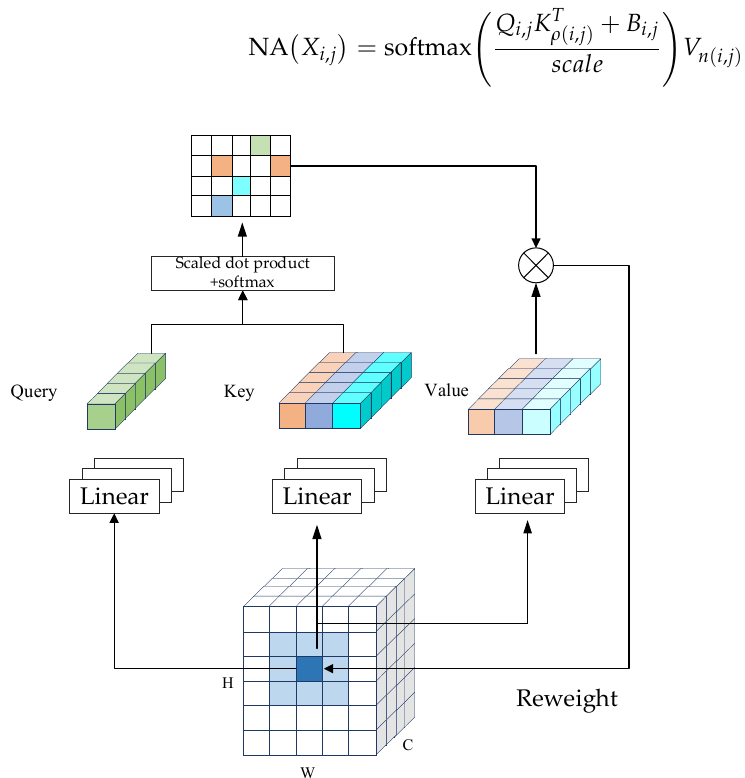
Figure 5. Neighborhood